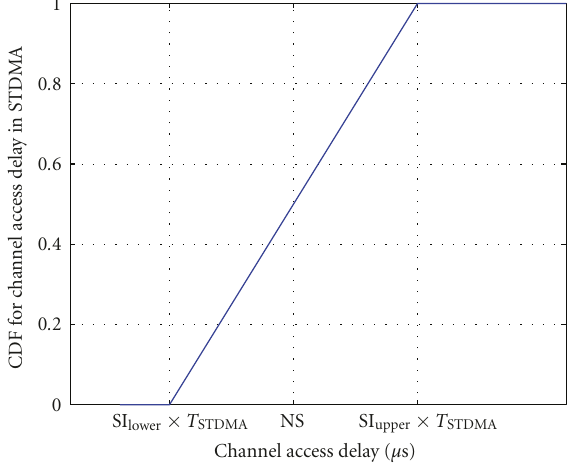
Figure 7: The CDF for channel access delay when using